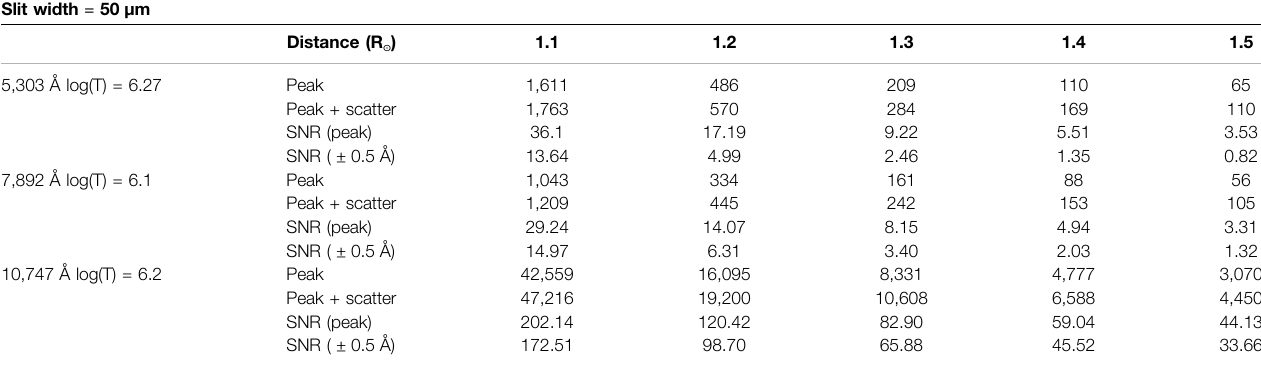
TABLE 4 | SNR for the VELC spectral channels for a slit width of 50 μ m, taking the line formation peak temperature for each channel. Slit width = 50 μ m Distance (R ʘ